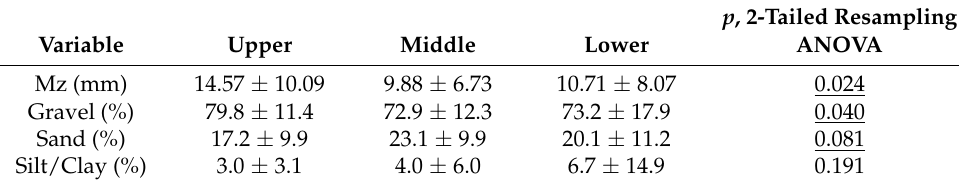
Table 3. Comparison of Mean Particle Size (Mz), percent gravel, sand, and silt/clay in upper (0–5 cm), middle (5–10 cm), and lower (10–15 cm) horizons in bulk sediments collected from 37 beaches in Prince William Sound in June 2010. Underlined p -values indicate significant differences. Variable